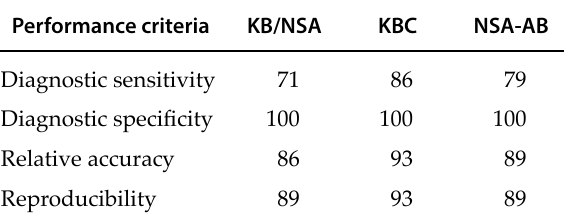
Table 2. Performance criteria obtained by isolation on ge- neric (KB/NSA) and semi-selective media (KBC and NSA- AB). All values were expressed in percentages